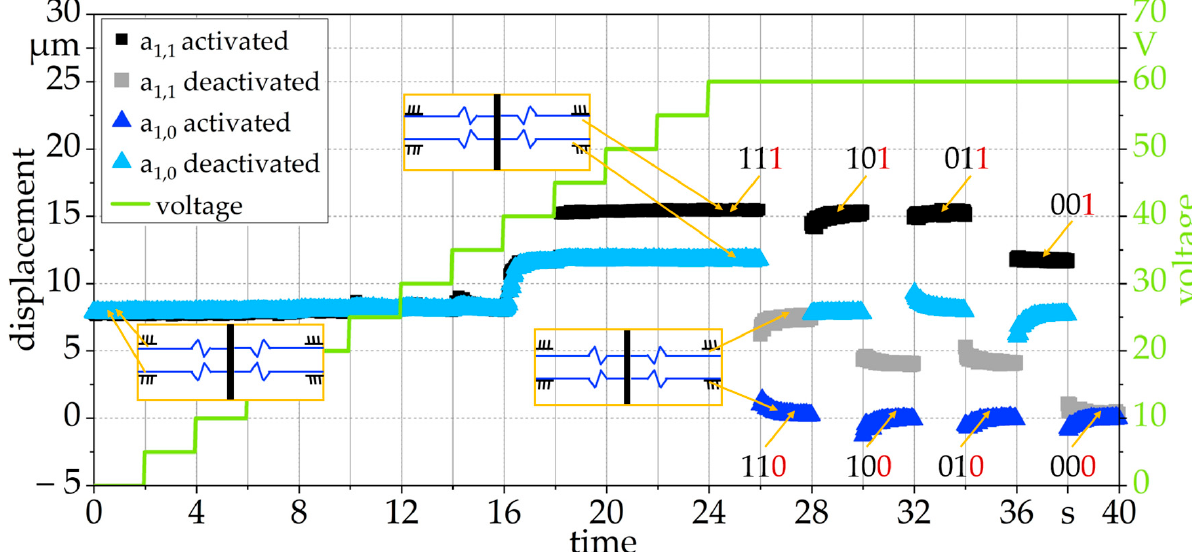
Figure 11. Displacement of the actuators a 1,1 and a 1,0 of the LSB of system. First, the voltage is increased from 0 V to 60 V in 5 V-steps every 2 s. At 60 V, the voltage remains stable while switching every 2 s in logical order from the 111 to 000 position.